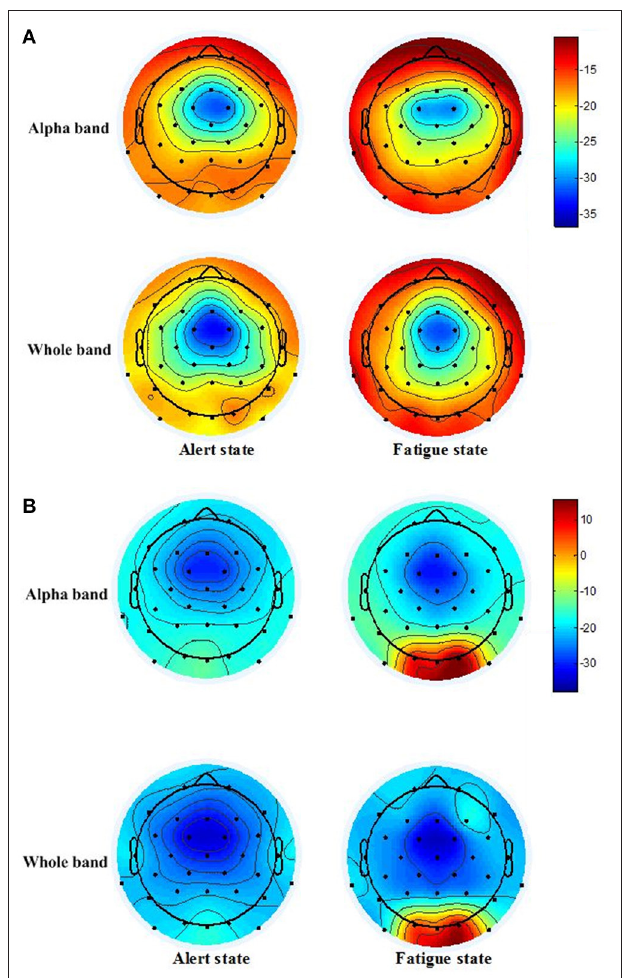
FIGURE 8 | Power spectral density (PSD) distributions of EEG signals for subjects 1 and 3. (A) PSD distributions of the alpha band of EEG signals in the alert state (a1) and in the fatigue state (a2). PSD distributions of the whole band of EEG signals in the alert state (a3) and in the fatigue state (a4) for subject 1. (B) PSD distributions of the alpha band of EEG signals in the alert state (b1) and in the fatigue state (b2). PSD distributions of the whole band of EEG signals in the alert state (b3) and in the fatigue state (b4) for subject